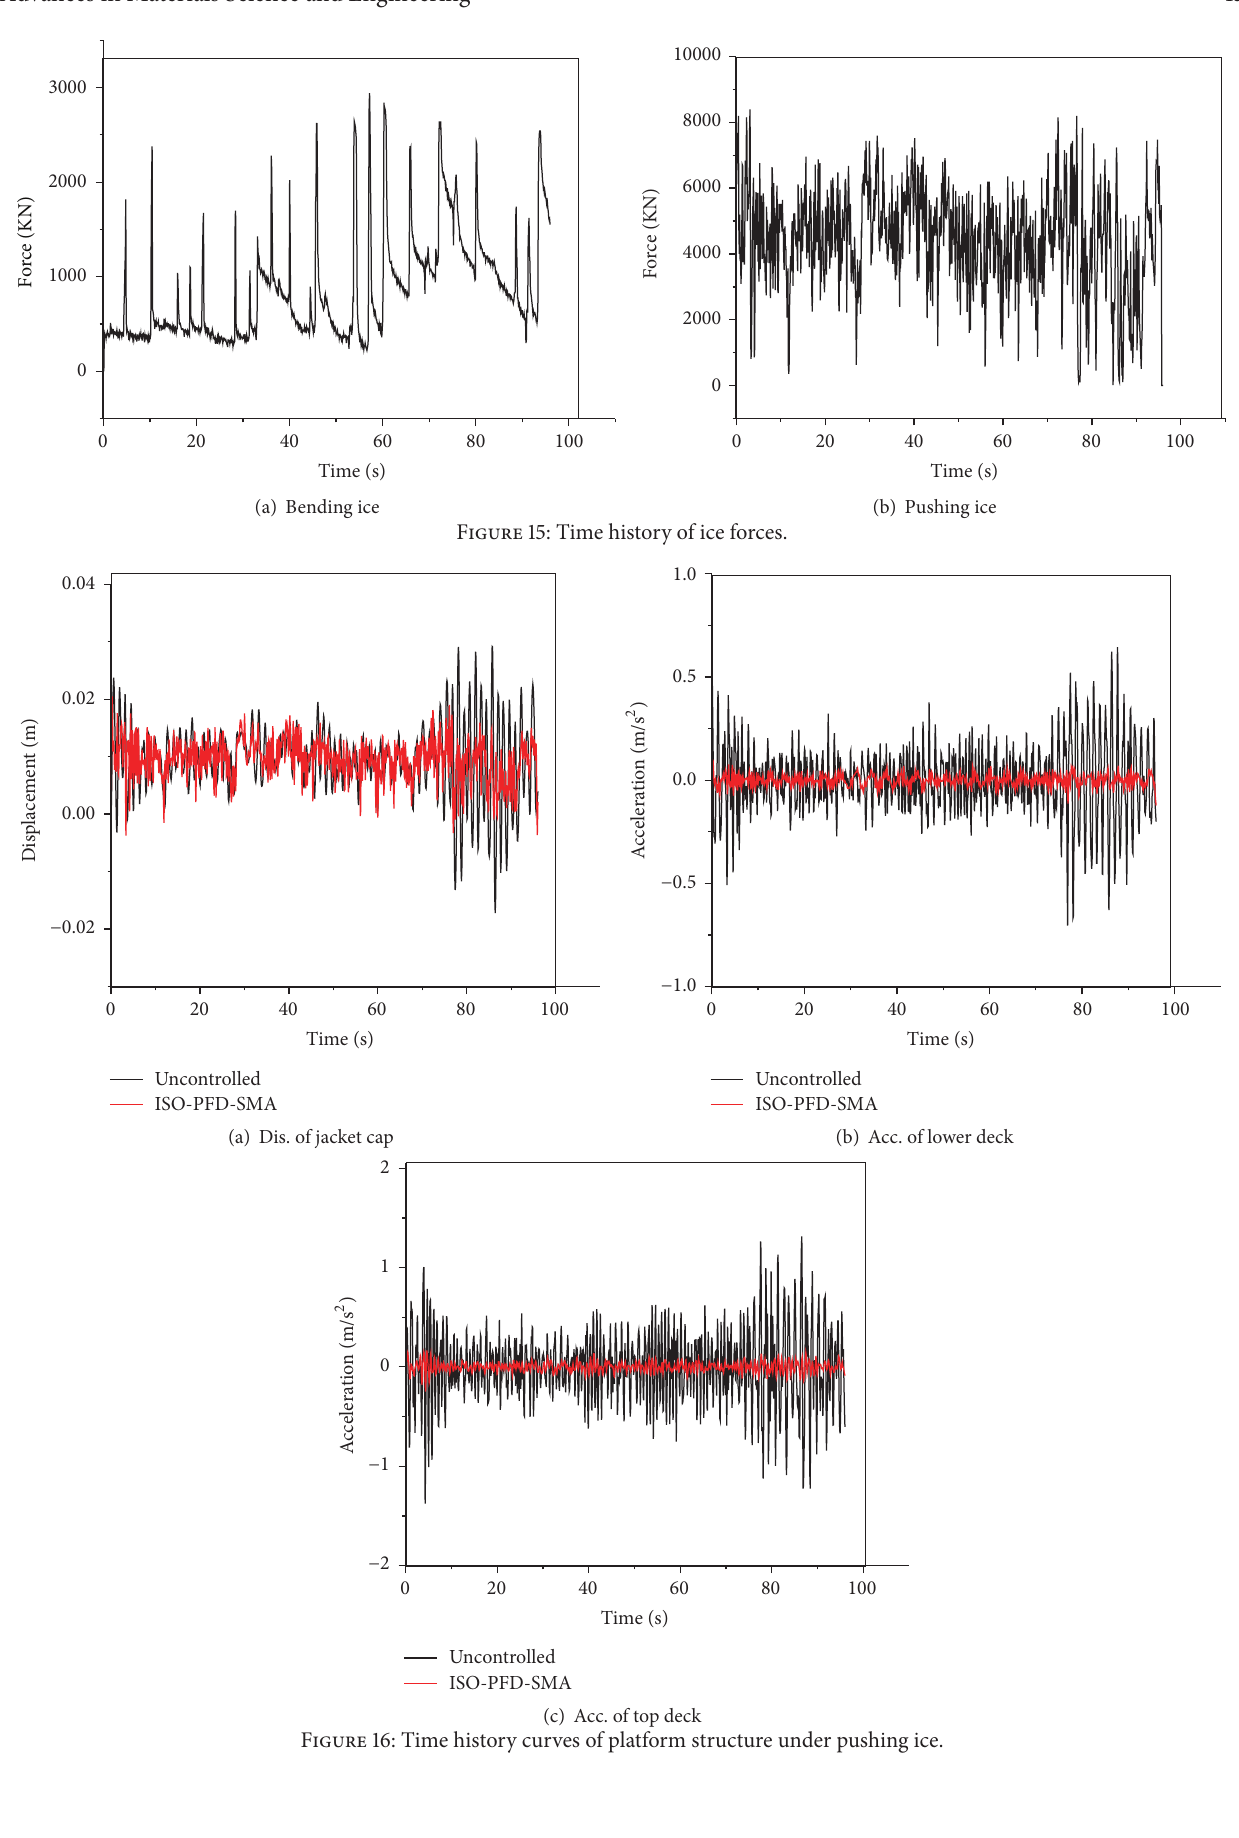
Figure 16: Time history curves of platform structure under pushing